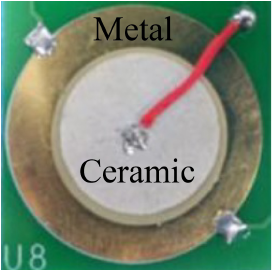
Figure 2. The piezoelectric ceramic sensor.